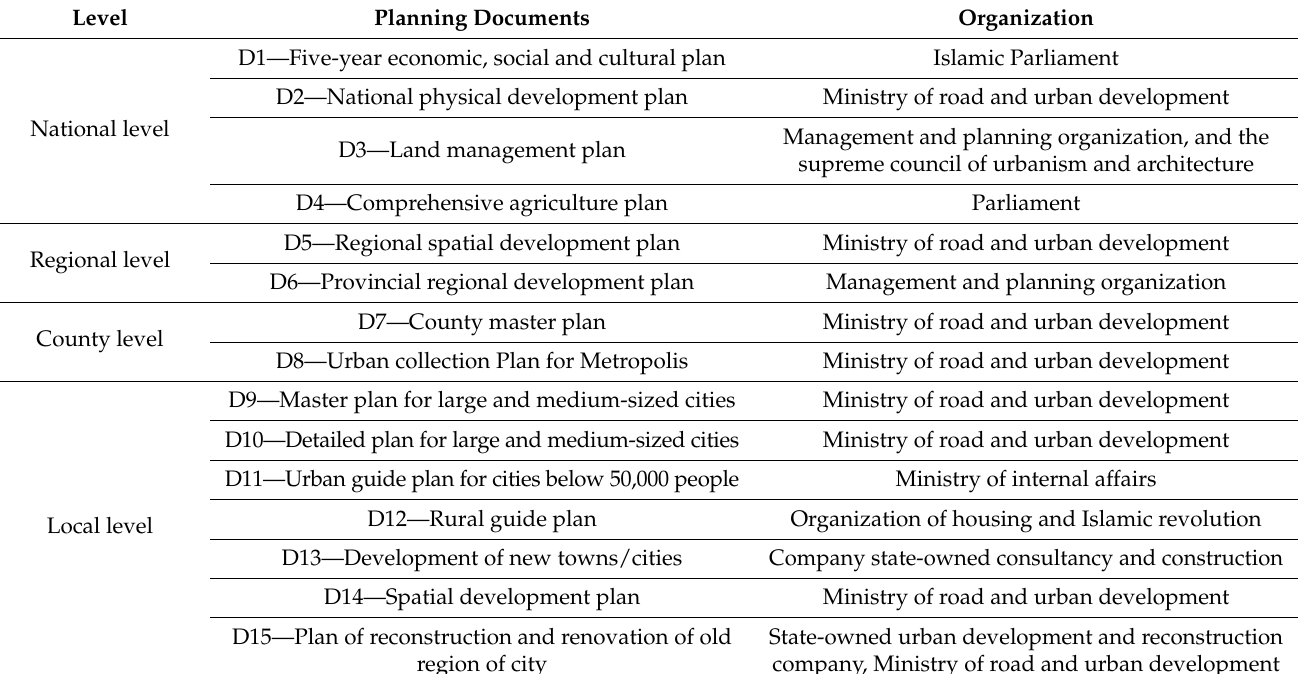
Table 1. Urban and regional development plans in